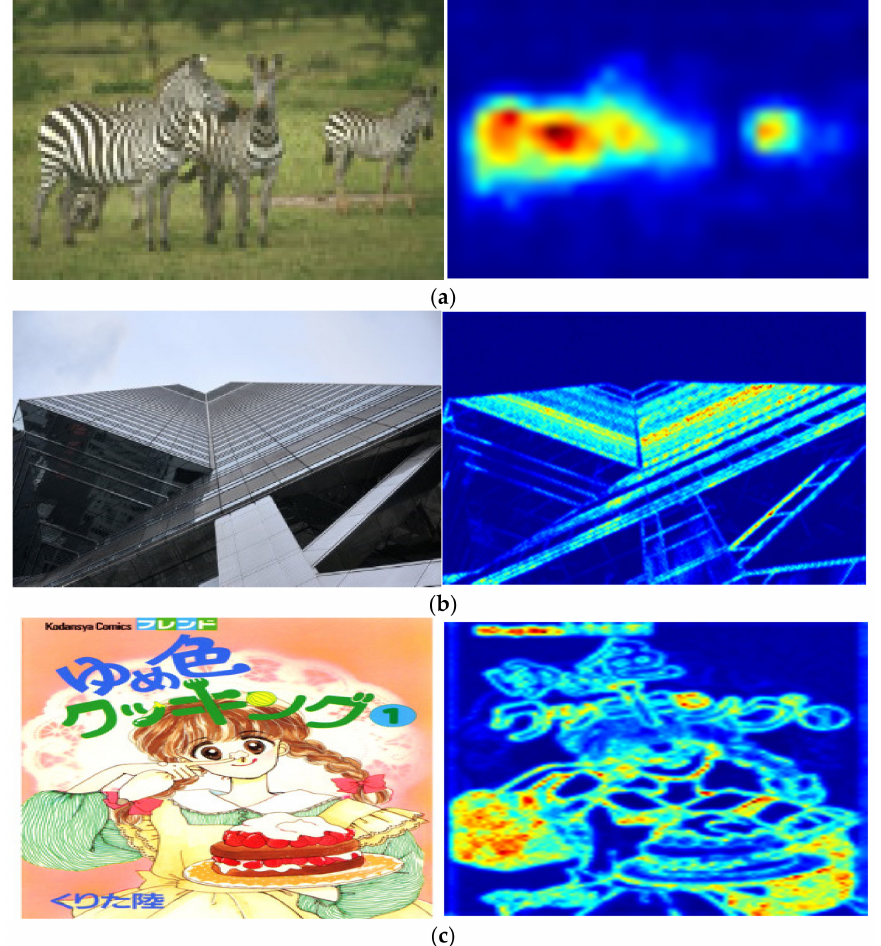
Figure 3. Visualization of dynamic convolution weights that are generated by our proposed approach. The first column presents the original test images, and the second column presents the visualized convolution weight variation values calculated using Equation (10). ( a ) 253027 from B100 dataset [19].